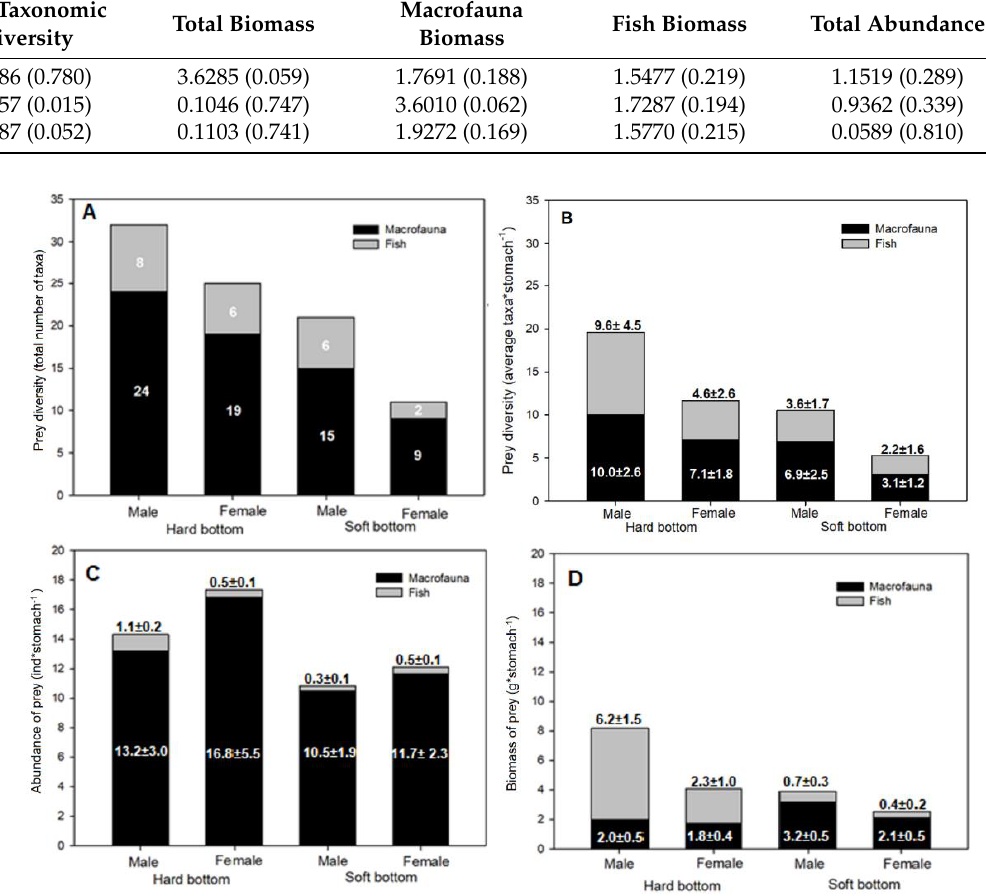
Figure 2. Diversity of prey as ( A ) total number of prey taxa, and ( B ) average number of taxa per stomach; ( C ) average abundance of prey (ind stomach −1 ) and ( D ) average biomass of prey (g stomach −1 ) for two major prey groups of long-tailed ducks collected in hard- and soft-bottom habitats. Labels indicate ( A ) the number of prey taxa, ( B ) the average prey abundance and standard error, and ( C ) the average prey biomass and standard error.